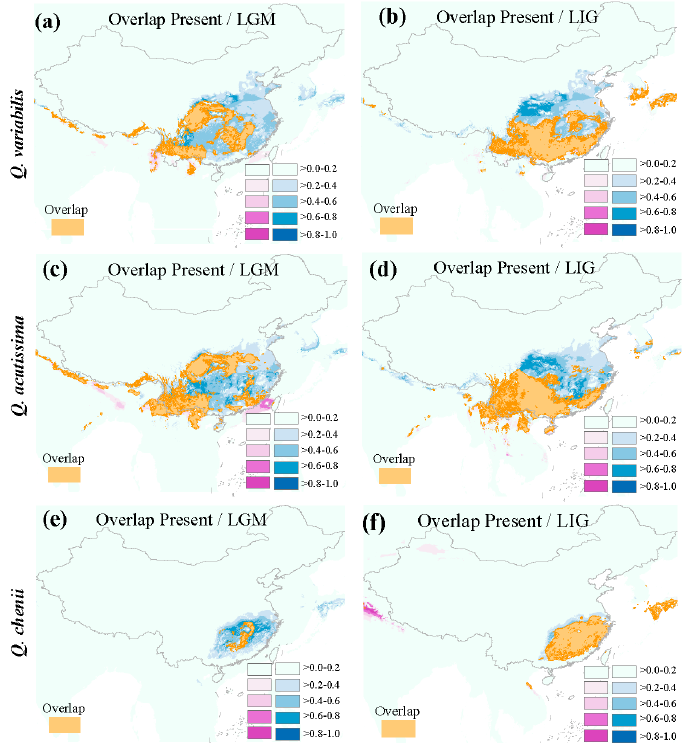
Figure 3. A comparison of potential habits under the present climate and two past climatic scenarios. ( a , b ) Overlap areas of the LGM and LIG with the present for the Q. variabilis , respectively; ( c , d ) Overlap areas of the LGM and LIG with the present for the Q. acutissima, respectively; ( e , f ) Overlap areas of the LGM and LIG with the present for Q. chenii , respectively. The blue and purple represent the present and past potential distribution, respectively. The orange represents the overlap of present and past potential distribution.